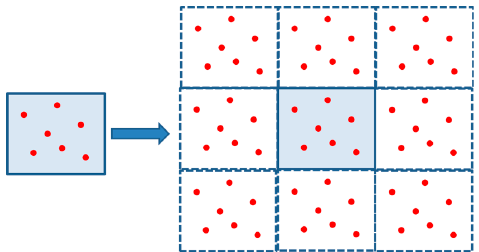
Figure 6. Creation of a periodic set of Voronoi vertices for implication of a periodic microstructure. A detailed step-by-step procedure of the proposed meshing algorithm is shown below.